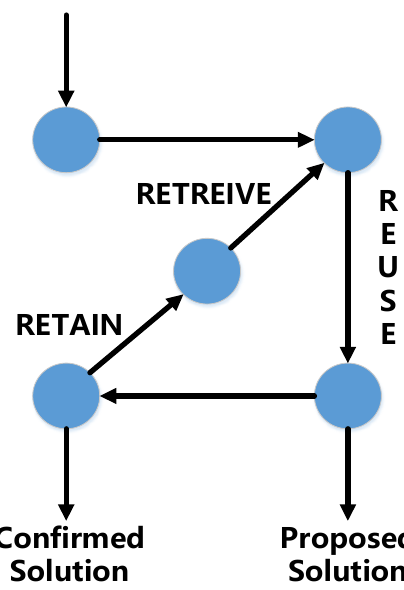
Figure 2. Case-based learning process.